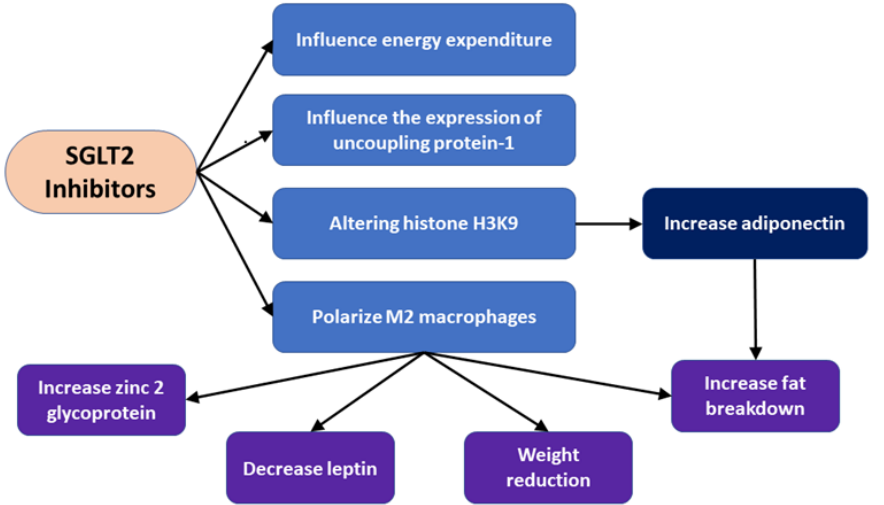
Figure 3. Effect of SGLT2 inhibitors on adipose tissue.